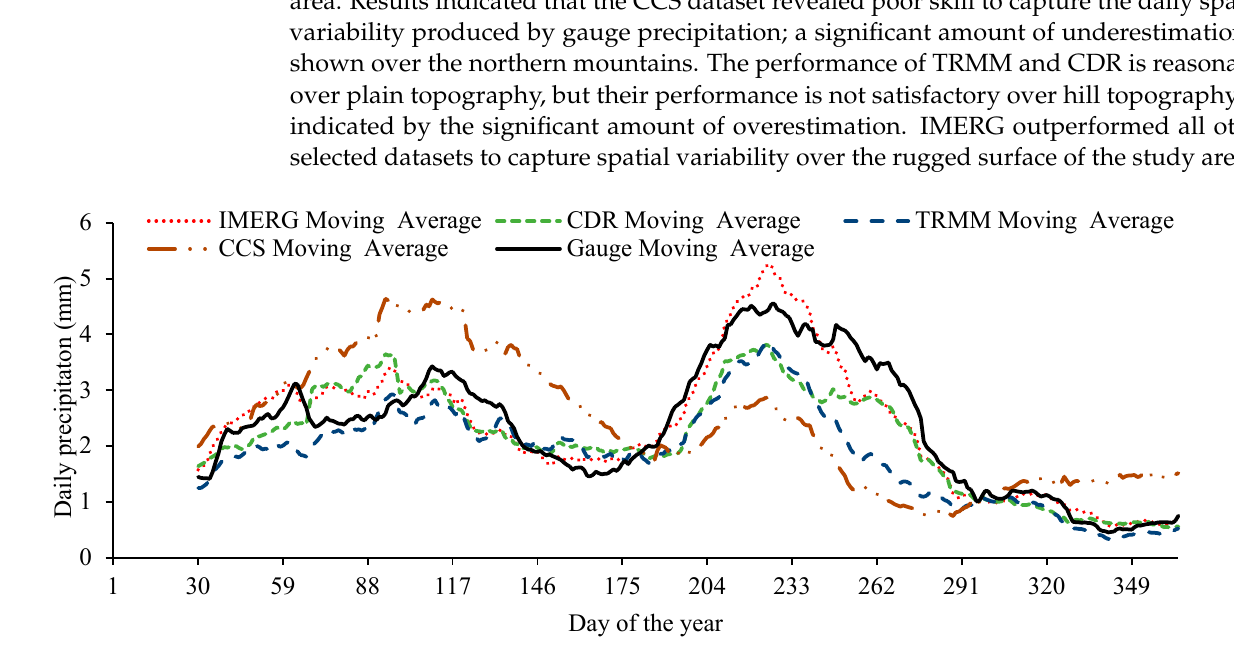
Figure 6. Comparison of moving averages of all SBPD and gauge estimations.